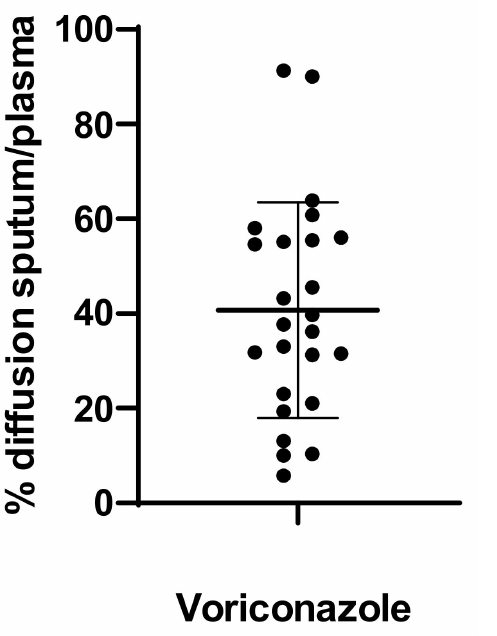
Figure 1. Percentage of voriconazole diffusion rate between sputum and plasma.